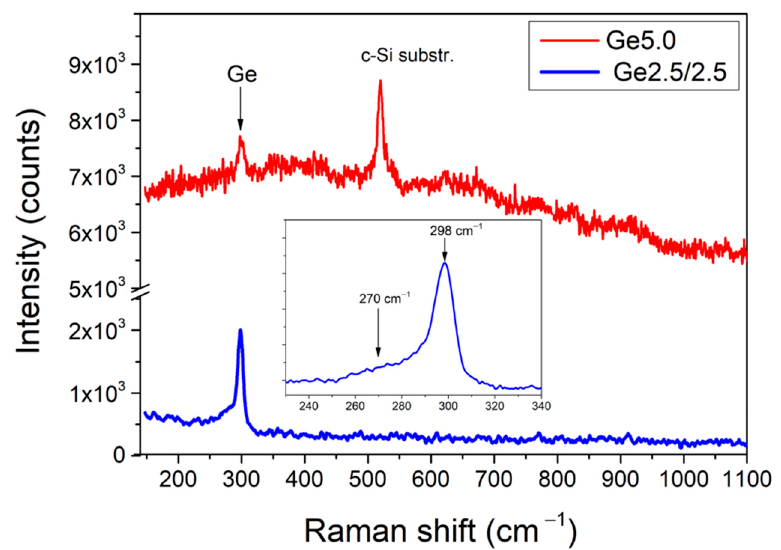
Figure 4. Raman spectra from Ge NPs obtained by grinding of laser-ablated Ge-based nanostructured films. Red curve (upper spectrum) and blue curve (lower spectrum) correspond to samples Ge5.0 and Ge2.5/2.5, respectively. Inset shows a selected region of the Raman spectrum of the dried small size fraction of Ge2.5/2.5 NPs.